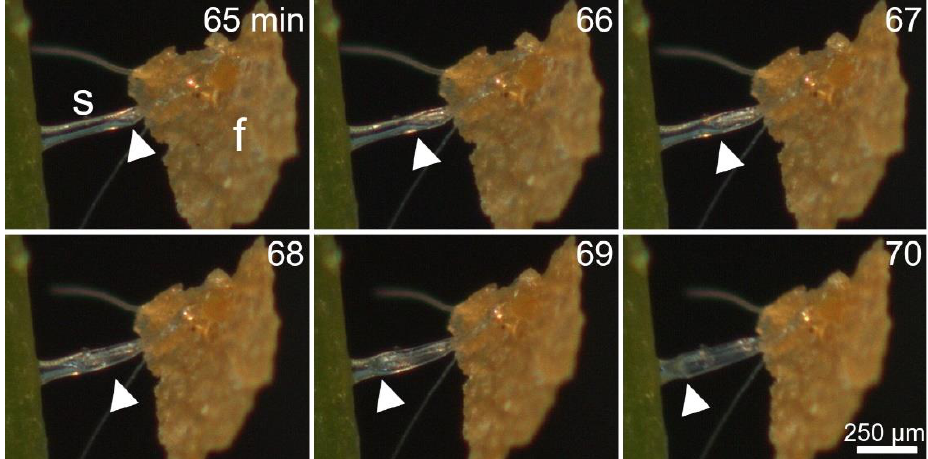
Figure 6. Deformation of the stalk cell (s) after stimulation with a fish food flake (f). The thick white arrows indicate the boundary region between the still cylindrical area and the already flattened area of the stalk cell, which proceeds towards its basal region over the course of time. Times [min] are indicated. The images are frames from Movie S6.